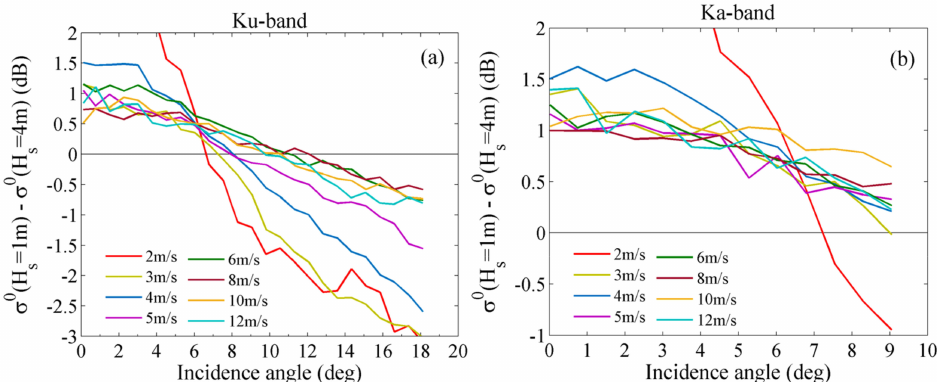
Figure 12. Magnitude of the difference of ( a ) KuPR σ 0 , ( b ) KaPR σ 0 between different significant wave heights ( H s = 1 m and H s = 4 m) as functions of incidence angle for different wind speeds from light to moderate